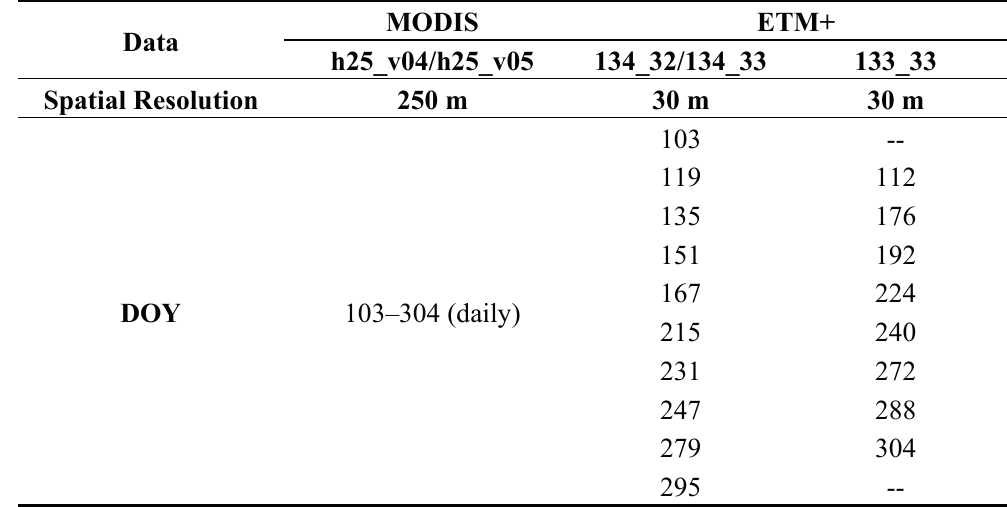
Table 1. Remote sensing data used for generating the high spatial and temporal resolution Normalized Difference Vegetation Index (NDVI) data.